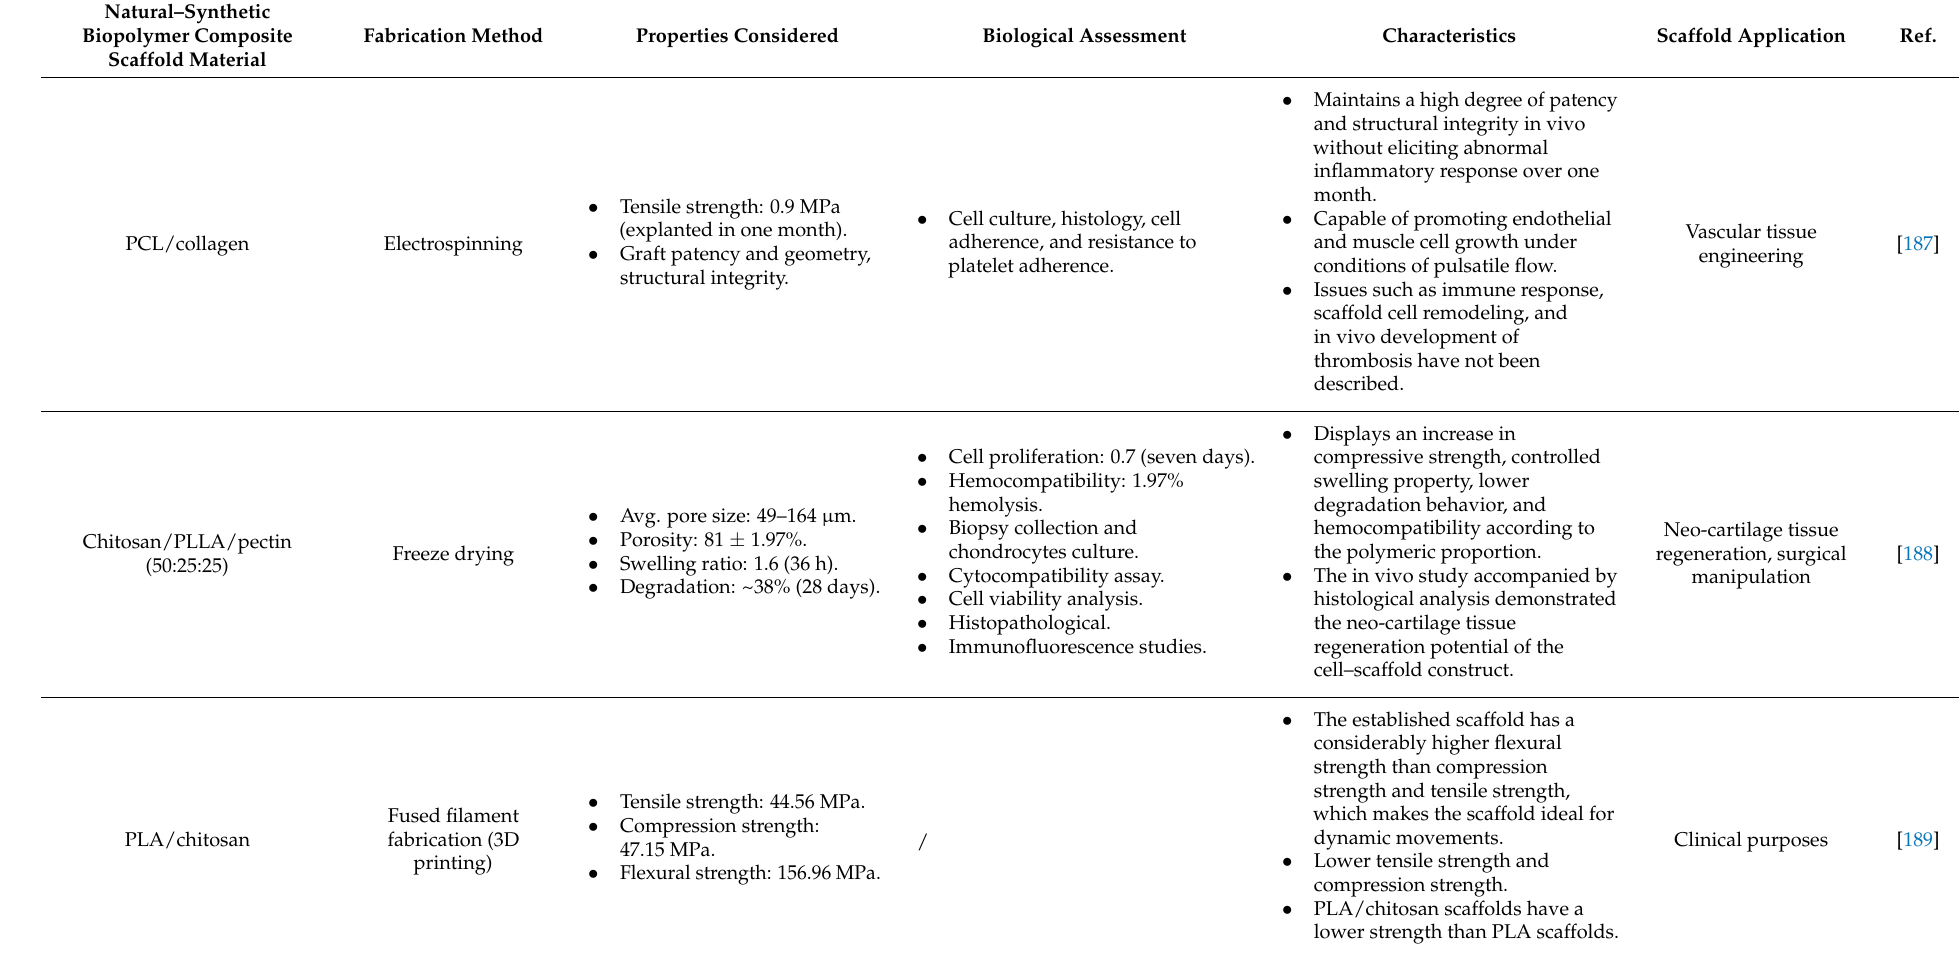
Table 3. Comprehensive analysis of natural–synthetic biopolymer blends (composites) along with their fabrication route, properties, biological assessment, and characteristics. Natural–Synthetic Biopolymer